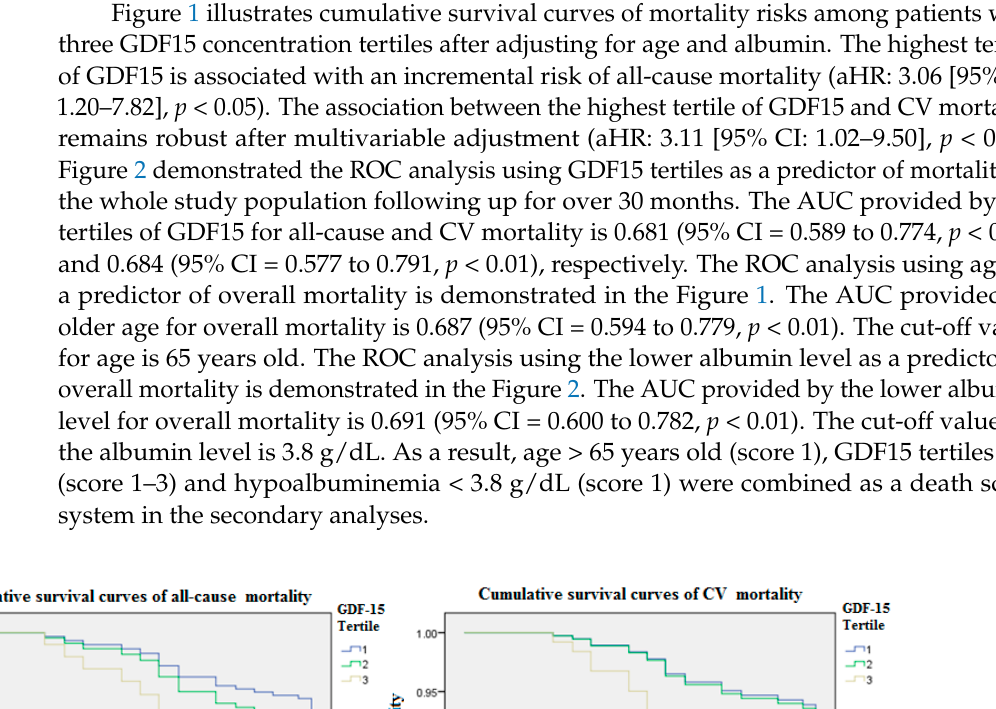
Figure 2. The ROC analysis of GDF15 tertiles for mortality showed suboptimal discriminatory power in the whole study population over 30 months of follow-up. ( A ) The AUC provided by GDF15 tertiles for all-cause mortality was 0.681 (95% CI = 0.589 to 0.774, p < 0.01). ( B ) The AUC provided by GDF15 tertiles for CV mortality was 0.684 (95% CI = 0.577 to 0.791, p < 0.01). Source of the curve: green line = GDF15 tertiles; blue line = reference. AUC = area under curve; CV = cardio- vascular; GDF15 = growth differentiation factor-15; ROC = receiver operating characteristics. 3.2. Secondary Analyses: Evaluation of the GDF15-Based Death Prediction Model Table 4 summarizes the bio-clinical data and fatal events according to our GDF15-based risk score system. Three GDF15 concentration tertiles are designated as scores 1, 2 and 3. Scores 1 or 0 of the clinical predictors are defined by the cut-off value of the ROC analysis. All patients are stratified by the GDF15-based risk score system into new categories. Figure 3 shows the comparison of ROC analysis between GDF15 tertiles and the GDF15-based risk score model for mortality in the whole study population over 30 months of follow-up. The AUC provided by the GDF15-based risk score model for all-cause mortality is 0.745 (95% CI = 0.666 to 0.824), and CV mortality 0.715 (95% CI =